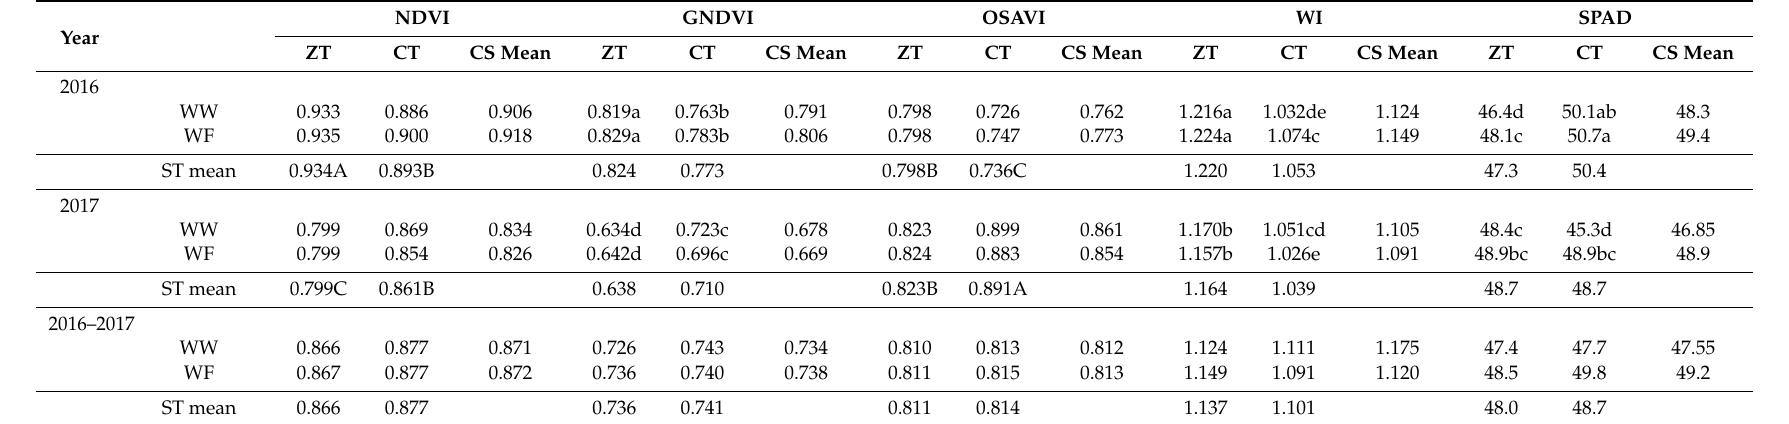
Table 7. Vegetation indices (NDVI: normalized vegetation index; GNDVI: green normalized di ff erence vegetation index; OSAVI: soil-adjusted vegetation index optimized; WI: Water index) and SPAD values as recorded for durum wheat at the soft dough kernel stage (DC85) in 2016 and 2017 cropping seasons. Means followed by di ff erent letters (upper case letters: main e ff ects; lower case letters: e ff ects of interaction) significantly di ff er according to Tukey’s HSD test ( p < 0.05). Treatments: CT, conventional tillage; ZT, zero tillage; WW, durum wheat monocropping; WF, durum wheat-faba bean